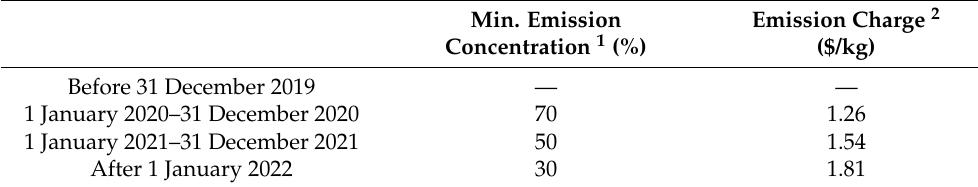
Table 3. NO x emission charge on business entities in South Korea (data taken from